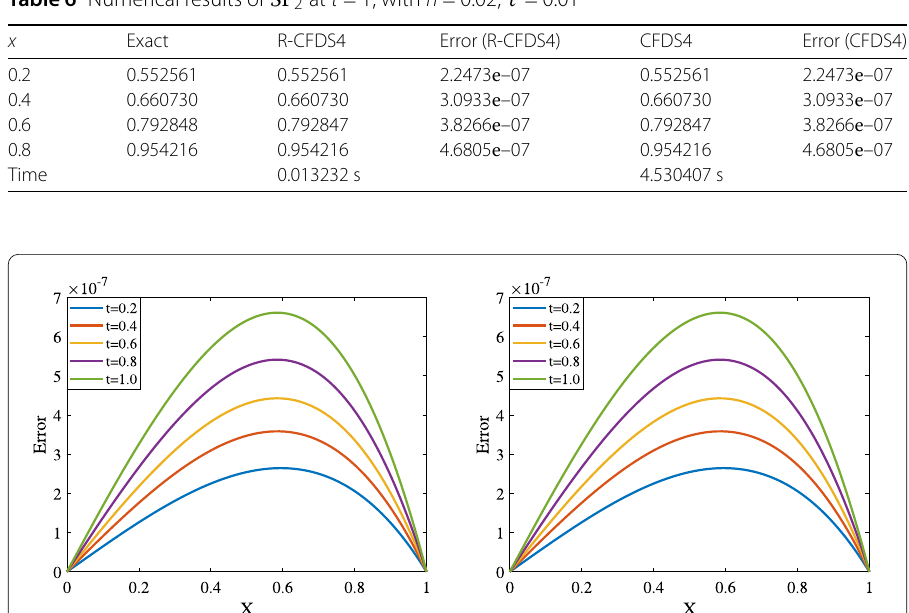
Table 6 Numerical results of SP 2 at t = 1, with h = 0.02, τ = 0.01